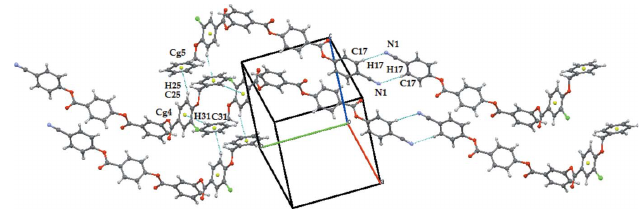
Figure 2 The molecular packing of the title compound. Dashed lines indicate the